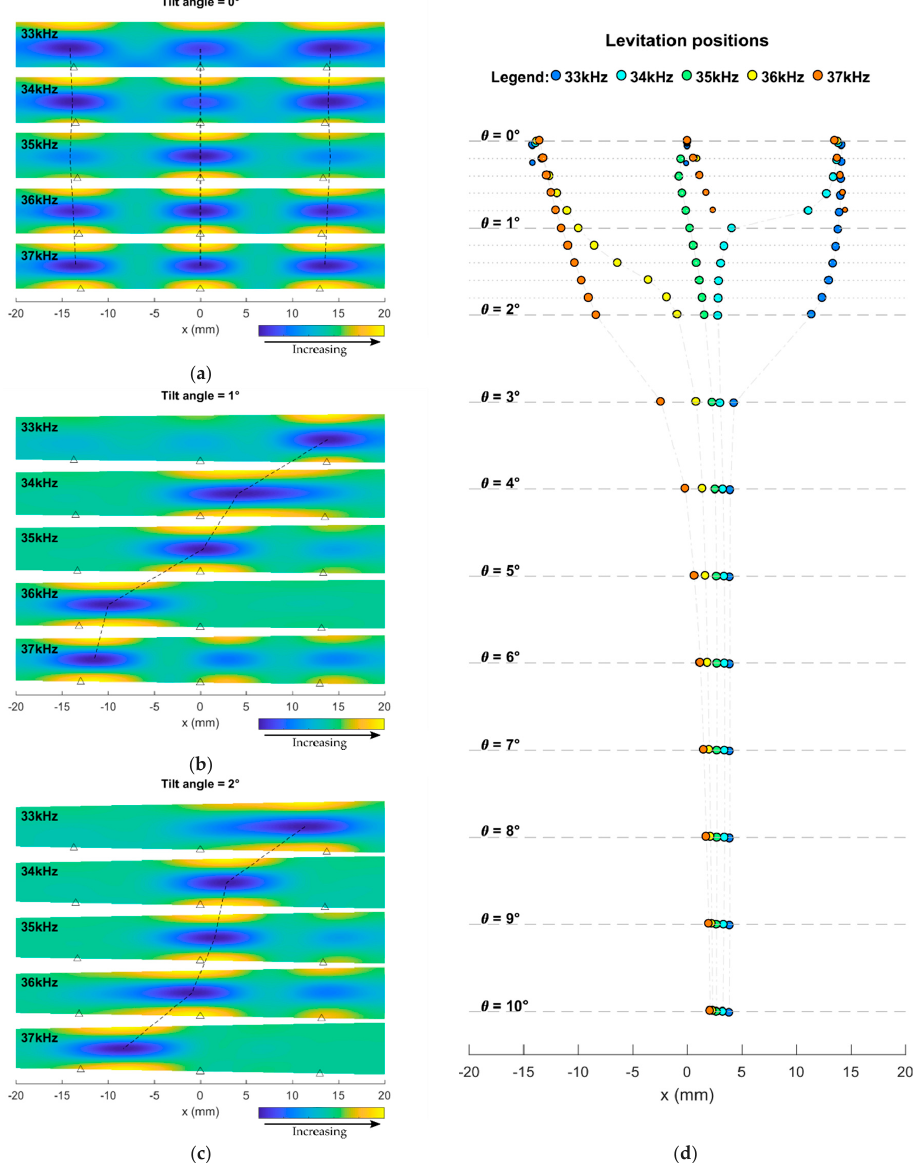
Figure 4. Normalized potential at the frequencies of 33–37 kHz for three different tilting angles: ( a ) 0°, ( b ) 1°, and ( c ) 2°. Triangle symbols represent the flexural antinodes. Dashed lines guide the eye. ( d ) Levitation positions for the tilting angles of 0.0°–1.8° with step of 0.2° and the tilting angles of 2°–10° with step of 1°. Marker radius is inversely proportional to the potential value.